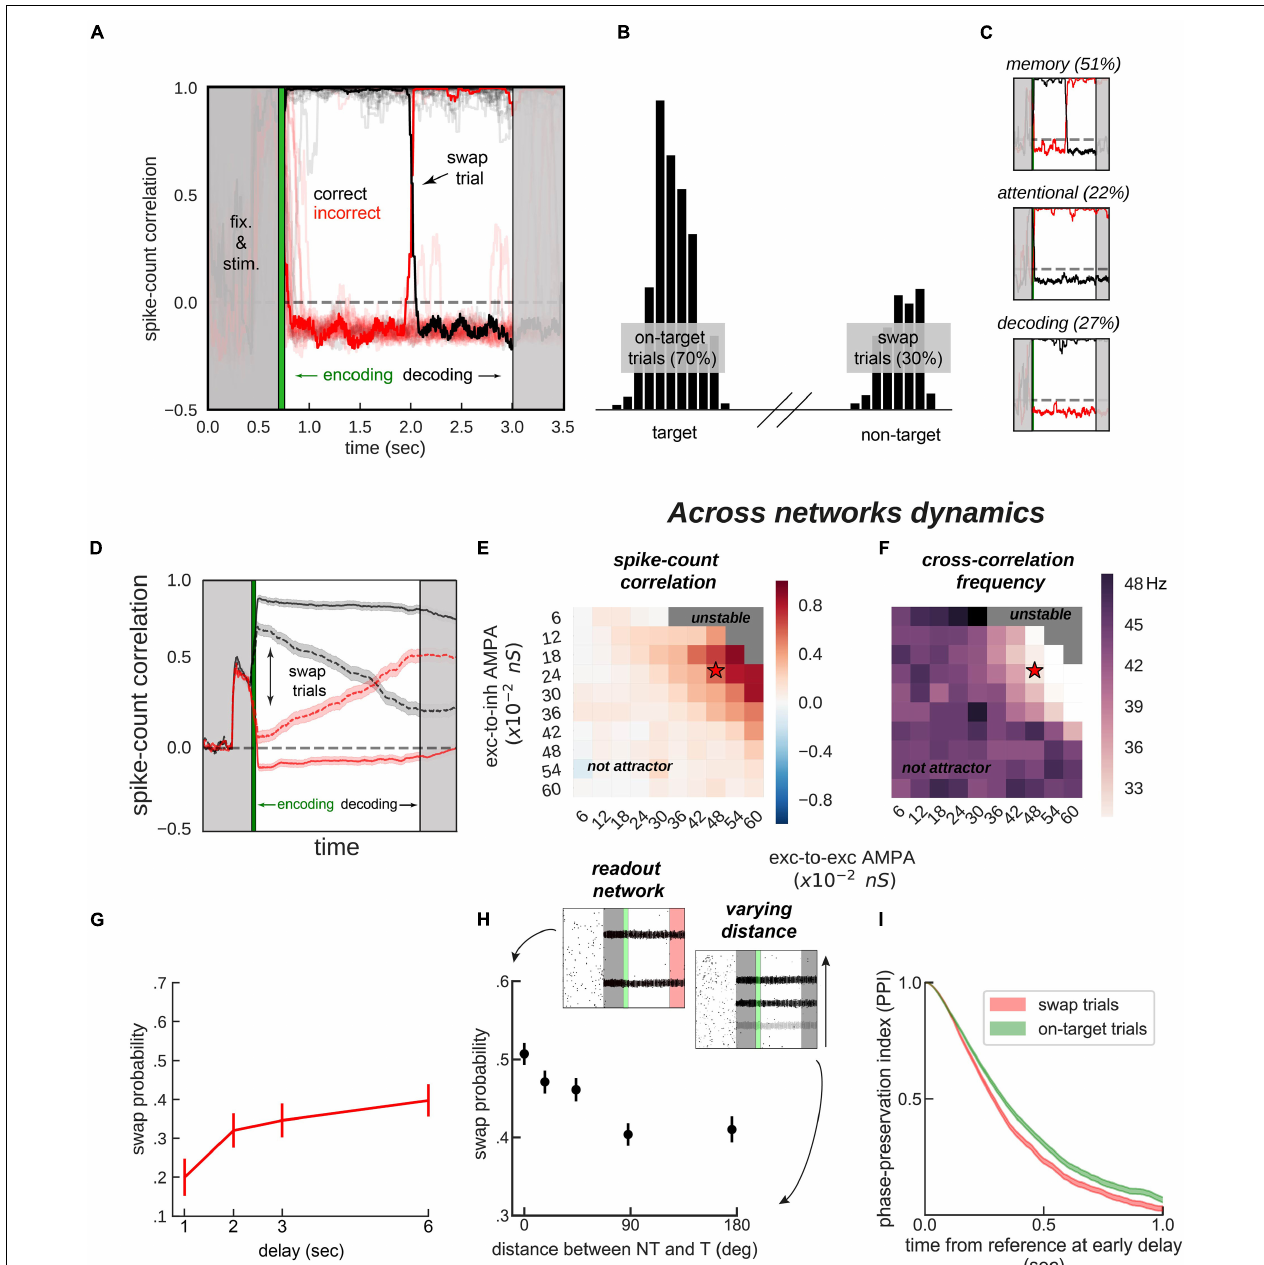
FIGURE 4 | Encoding and decoding without temporal precision. (A) Spike-count correlation (in count bins of 5 ms and correlation windows of 100 ms) during the delay for 20 sample simulations. During the encoding period (green), immediately after the stimulus presentation, we bound two bumps, one from each network, by simultaneously stimulating them strongly. This ensured those two bumps were correlated through the trial more often than chance (black lines in the figures), and the other cross-network association synchronized mostly out-of-phase (red lines). On some trials (only one in a), noisy fluctuations reversed these correlations suddenly (swap trials). During the decoding period (light gray, on the right) we simulated the probe period of a working memory task, by stimulating the cued location (0.5 s) of one network, while decoding mean firing rates from the color network. (B) Color readout histogram in 1,000 simulations. Bumps bound during encoding (target, centered at neuron 520 out of 2,048) were more likely to be read-out than unbound bumps (non-target, centered at 1,480). (C) Three types of swaps: memory swaps (top), attentional swaps (middle), or decoding swaps (bottom). (D) Same as panel (A) , averaging across all trials separately for swap and on-target trials, as defined by the decoder, shown in panel (B) . (E,F) summary of the dynamics of 22,000 simulations (total) of 100 connected ( × 2) networks as a function of inter-network connectivity. (E) Binding stability measured as the average spike-count correlation between initially bound bump pairs during the delay (black, in figures). (F) Dominant frequency of the cross-correlation between bound bump pairs. Red stars mark the parameter values of the model used for sample simulations. (G) Swap errors increase with delay duration and (H) simulations (3 s delay) where target (T) and non-target (NT) bumps are stored close-by